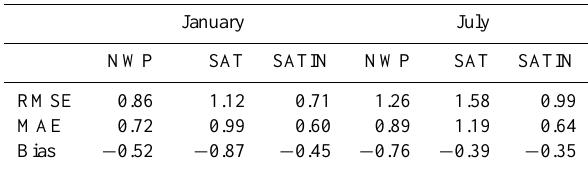
Figure 5. Validation of SATIN analyses with INCA analyses and comparison to ALARO and H03 (SAT) satellite precipitation prod- uct. Box plots of daily Structure, Amplitude, Location values for 5 cases with heavy precipitation. Table 3. Mean relative RMSE, MAE and Bias obtained from cross validation at 9 stations for January and July 2014. NWP refers to ALARO 5km while SAT refers to the HSAF H03